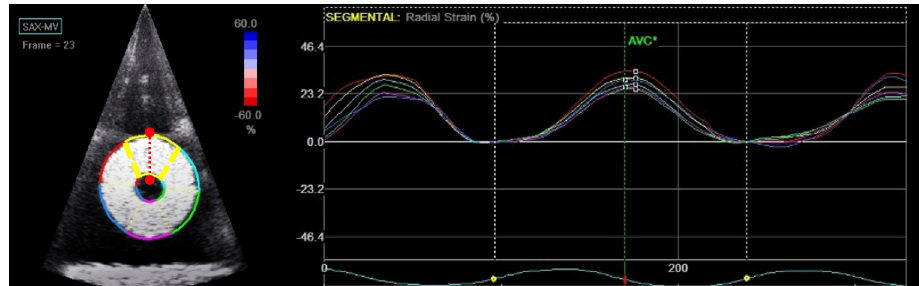
Fig 2. Speckle tracking echography of the phantom in short axis view. The software algorithm automatically segments the phantom into six regions. The positions of sonomicrometer crystals at the internal and external surfaces of the phantom are indicated in red. Peaks of strain versus time curves corresponding to the six segments are obtained (here for radial strain).